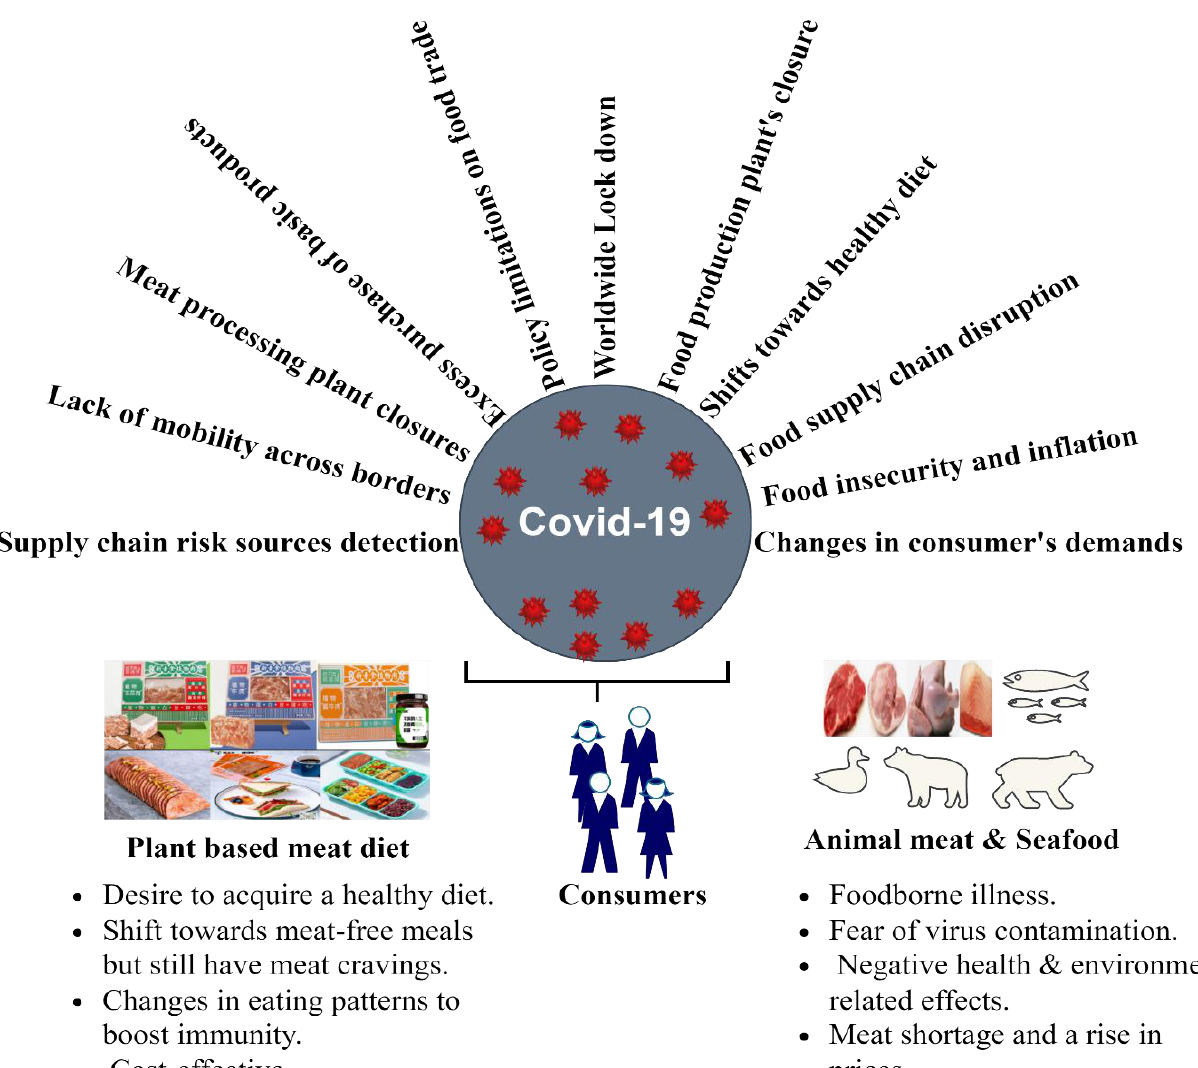
Figure 2. Changes in the food supply chain and the dietary behavior of people that occurred during the COVID-19 pandemic.